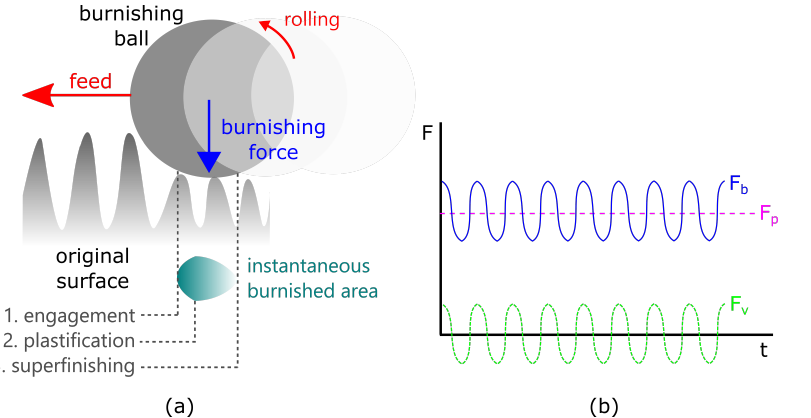
Figure 1. ( a ). General overview of a vibration-assisted ball burnishing process. ( b ). Components of the burnishing force ( F b